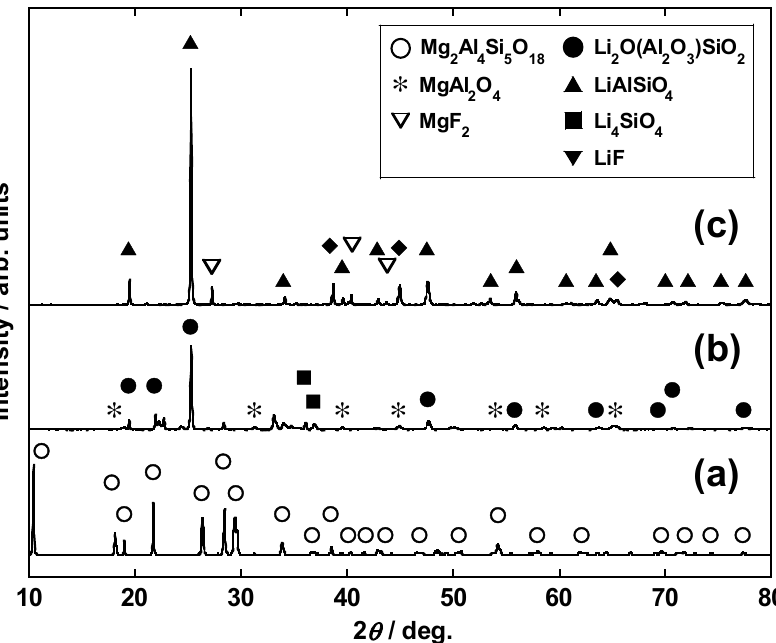
Figure 7. XRD profiles of the cordierite-containing calcined samples obtained under conditions ( a ) II-A, ( b ) II-B, and ( c ) II-C.